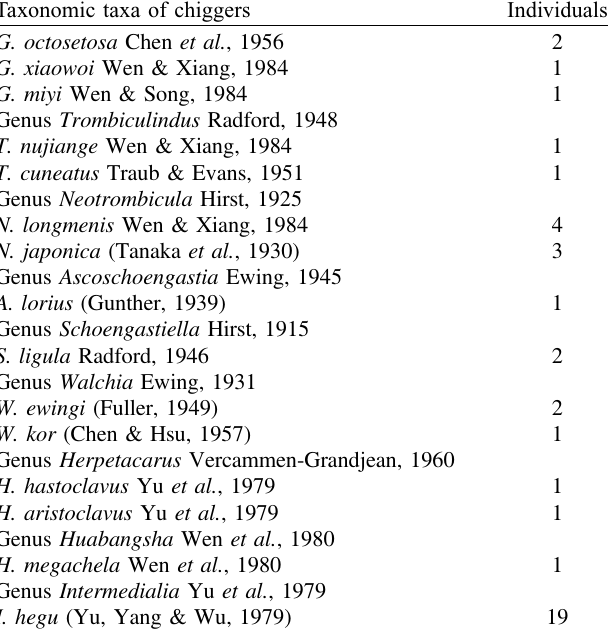
(houses, stables, barns and nearby surroundings) in comparison with the other three types of habitats (bushes, woodlands, and farmlands) (Table 4, p < 0.05). The species similarity of chiggers was low among different habitats ( J < 0.5). As shown in Table 4, the species richness and infestation indices of chiggers on A. squamipes in the mountainous land- = 23.3%, MA = 4.74 and MI = 20.38) were scape ( S = 68, P m much higher than those in the fl atland landscape ( S = 13, P = 5.0%, MA = 0.42 and MI = 8.55, p < 0.001). The species m similarity of chiggers was very low between two landscapes ( J = 0.10). Fluctuation of chigger infestation on different sexes and ages of hosts The prevalence ( P = 13.5%) and mean abundance m ( MA = 2.28) of chiggers on female A. squamipes shrews (hosts) = 8.2%, MA = 1.39) were higher than those on male hosts ( P m ( p < 0.05). The mean intensity ( MI ) on male hosts was higher than that on females, but the difference was not statistically signi fi cant ( p > 0.05). The species of chiggers on female shrews (60 species) were higher than those on male shrews (41 species) (Table 5). The chigger species on different sexes of A. squamipes showed low similarity ( J = 0.38). The prevalence of chiggers on adult A. squamipes hosts = 10.6%) was lower than that on juvenile hosts ( P m = 23.9%), but the mean abundance and mean intensity ( P m on adult hosts ( MA = 1.76) were higher than those on juvenile hosts ( MA = 1.52) ( p < 0.05). The mean intensity ( MI ) on adult hosts was higher than that on juvenile hosts, but the difference was of not statistically signi fi cant ( p > 0.05). Adult shrews harbored more species (69 species) than juvenile shrews (Continued on next